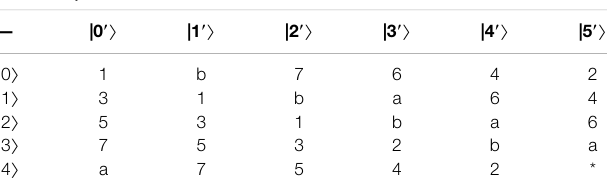
TABLE 2 | 7×3+2×4=29-member.